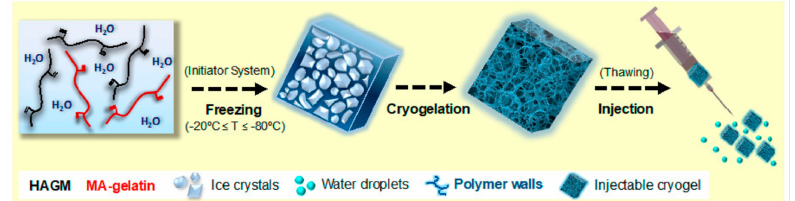
Figure 2. Schematic representation of the entire process involved in forming injectable cryogels. The methacrylate derivatives of HA (HAGM) and/or gelatin (MA-gelatin) are dissolved in water containing an initiator system. Then, it is frozen at three different temperatures: − 20, − 50 and − 80 ◦ C. Cryogelation occurs around the ice crystals. Interconnected spaces are obtained after melting at room temperature. Ultimately, macroporous cryogels can be injected successfully with a syringe through a 16 G hypodermic needle.